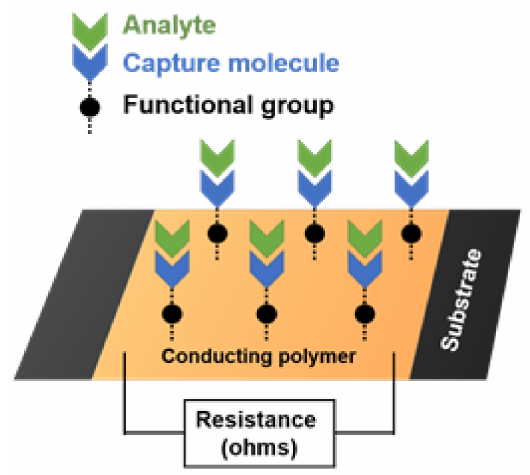
Figure 2. Schematic of chemiresistive sensor with capture molecule immobilization and analyte binding.